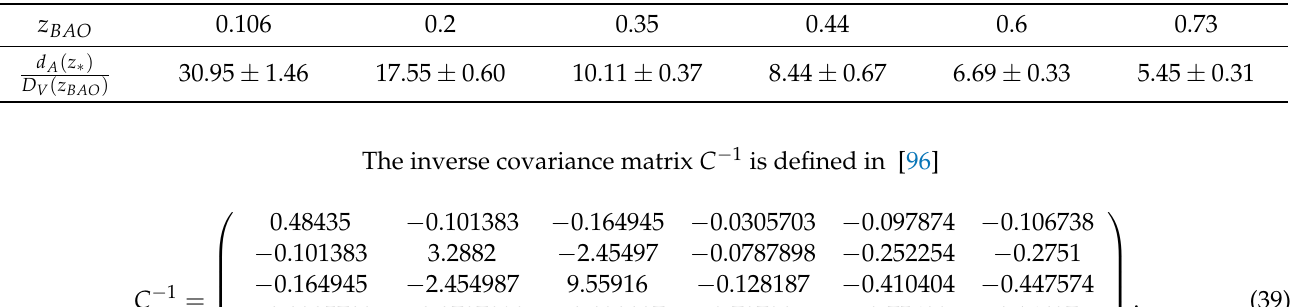
Table 1. Values of d A ( z ∗ ) / D V ( z BAO ) for distinct values of z BAO